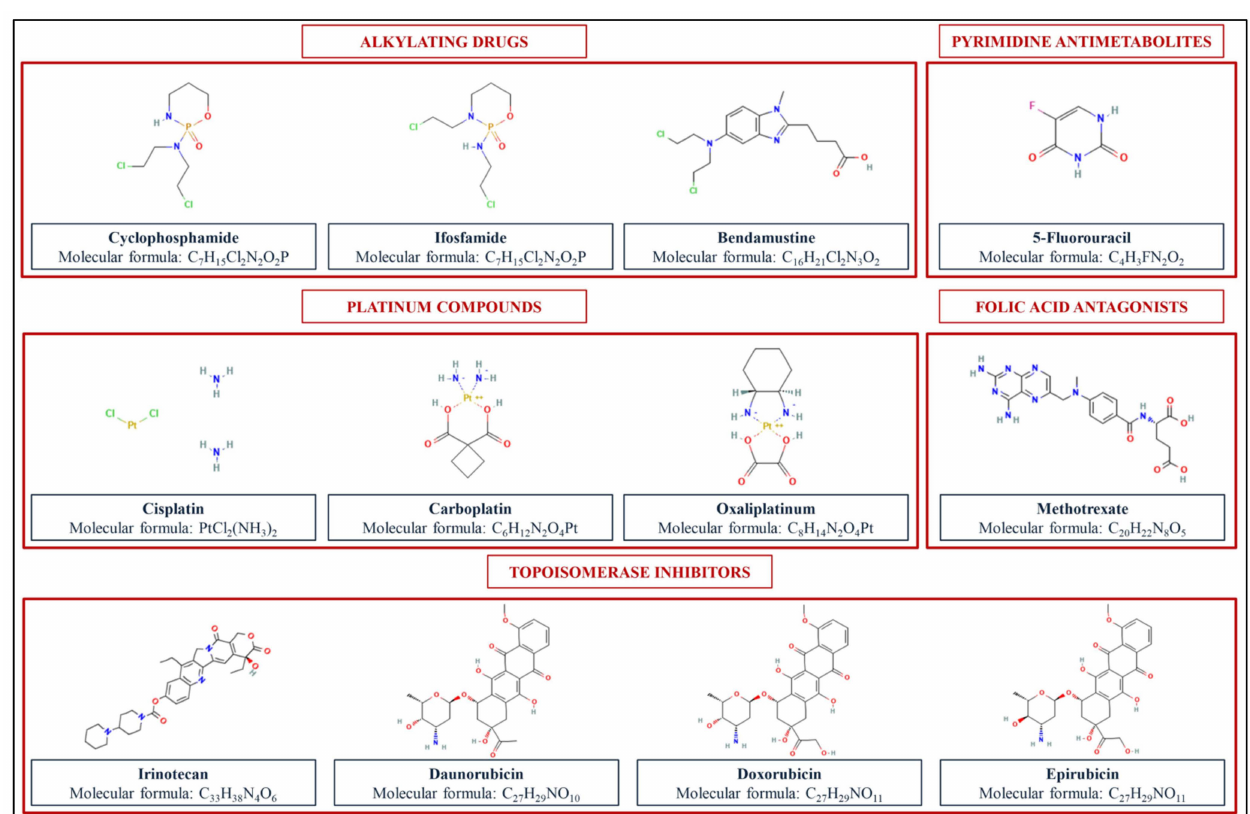
Figure 1. Chemical structures of the main ADs investigated by the studies object of this systematic review. The 2D structure images of the ADs in this figure were obtained from PubChem as